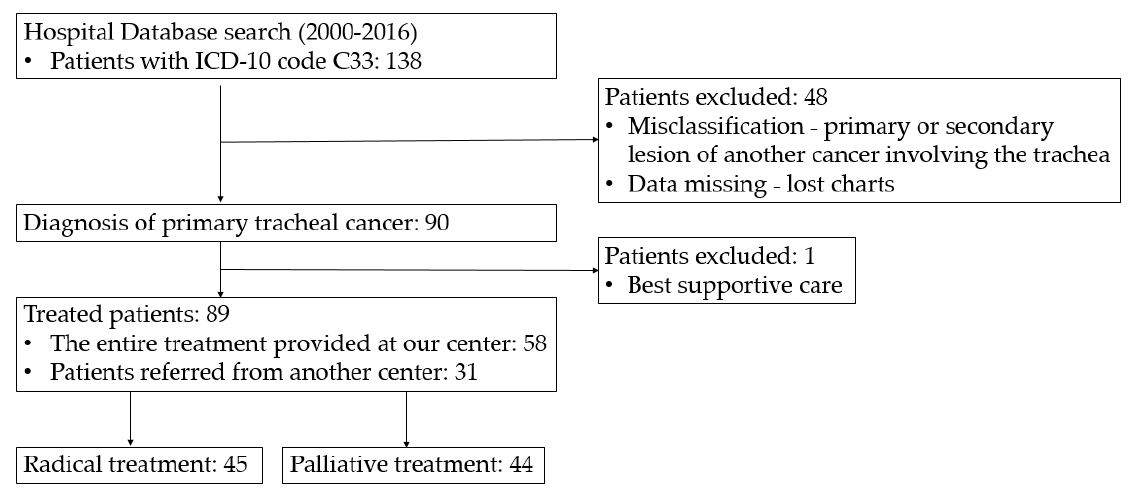
Figure 1. Patient identification algorithm and exclusion criteria.